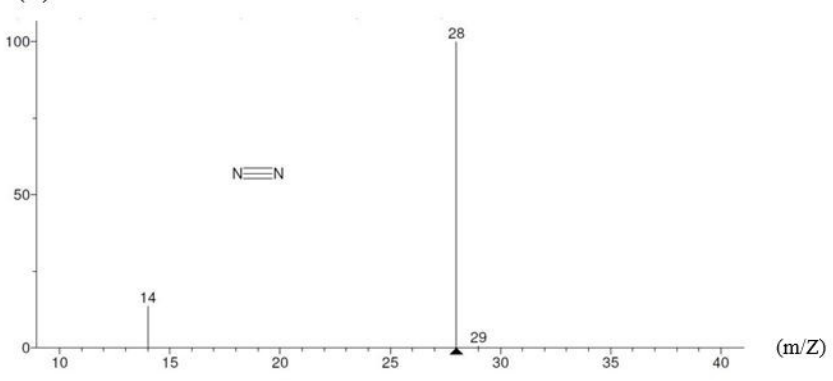
Figure 6. Substances and their molecular masses using a GC-MS test.